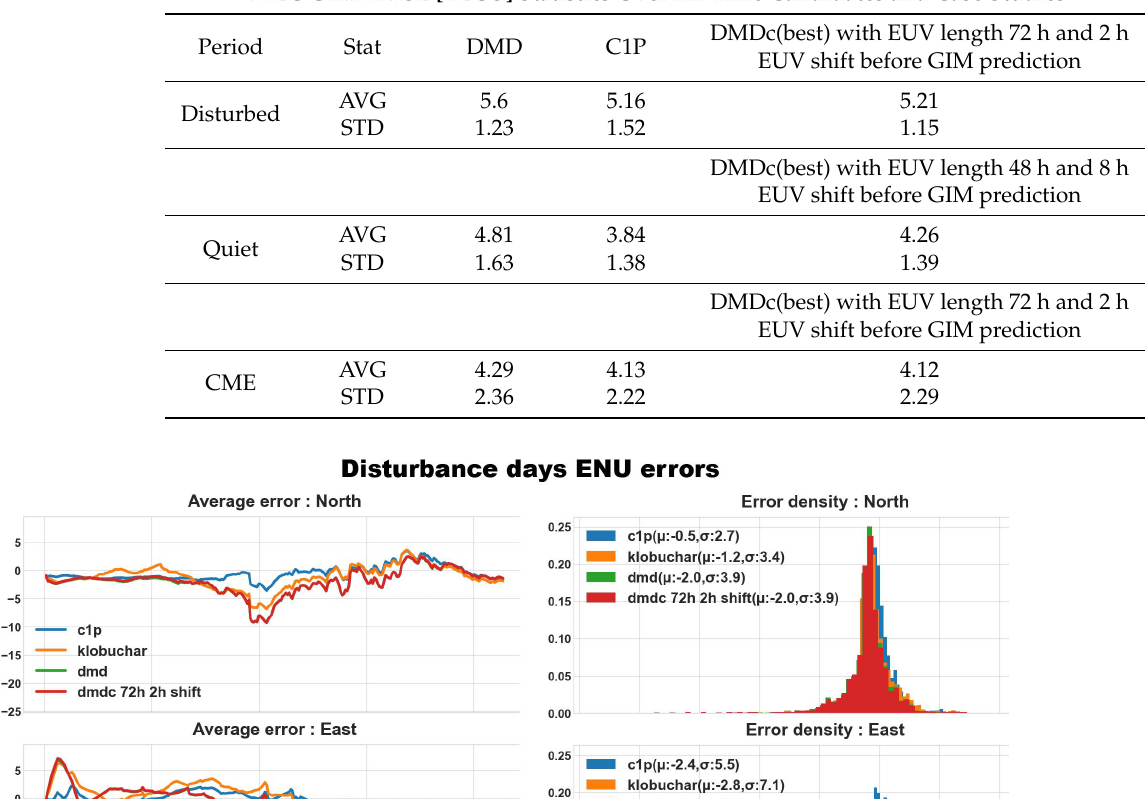
Table 2. Statistics for vTEC GIM RMSE over all time candidates and case studies, sorted by different solar activity periods.